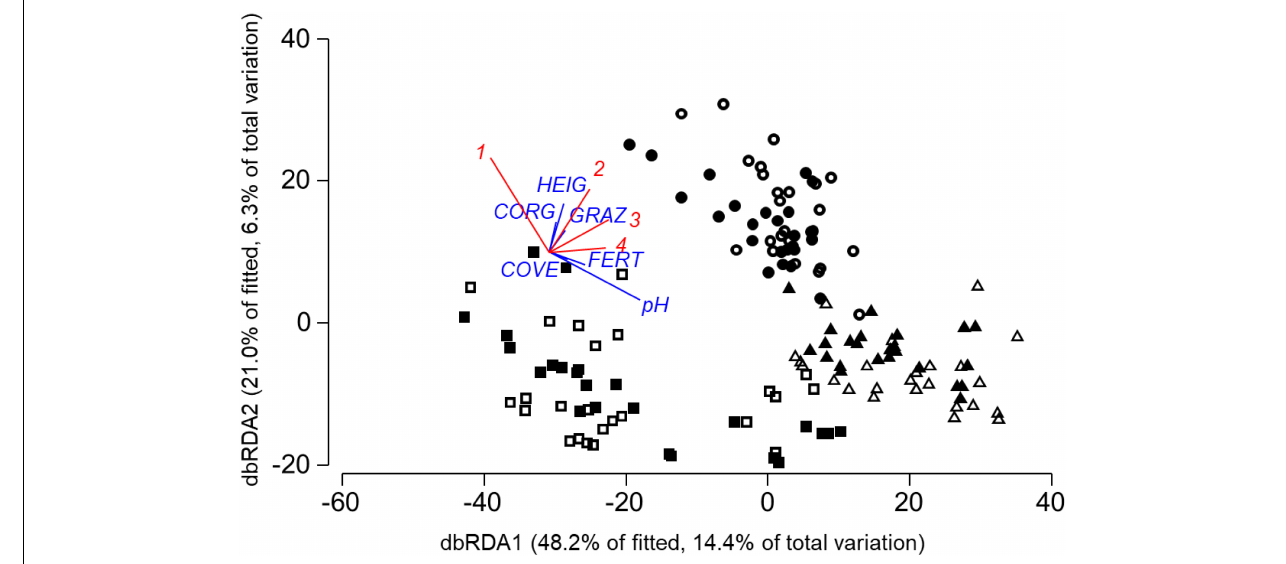
FIGURE 4 | Distance-based RDA plot of study plots based on Collembola community data and the model in Table 3D from AEG ( (cid:110) ), HEG ( (cid:108) ) and SEG ( (cid:115) ) with samples from spring (solid) and autumn (open) 2009. Individual predictor variables from selected indicator groups of the model in Table 3D are superimposed (CORG, soil organic carbon content; pH, soil pH value; GRAZ, average livestock density 2006–2008; FERT, average fertilizer amount 2006–2008; COVE, vegetation cover; HEIG, vegetation height). Collembola species with correlation coefficients > 0.3 between axis scores of sites and abundances are also superimposed with (1) Isotoma viridis, (2) Folsomia quadrioculata, (3) Lepidocyrtus lanuginosus, and (4) Parisotoma notabilis